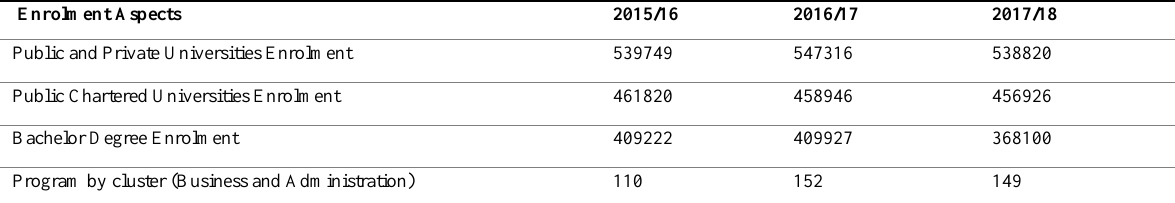
Table 1 : Enrolment Rates for the period